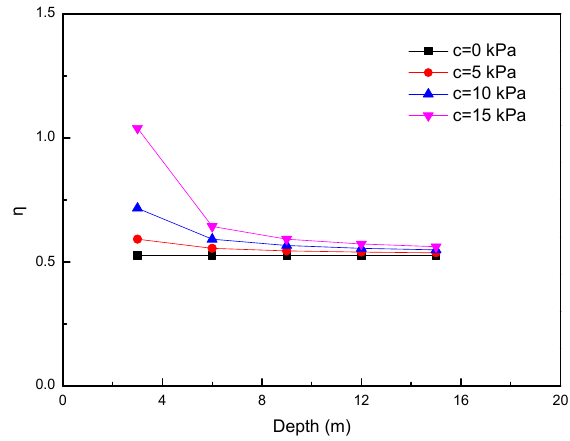
Figure 12. Influence of cohesion on η .